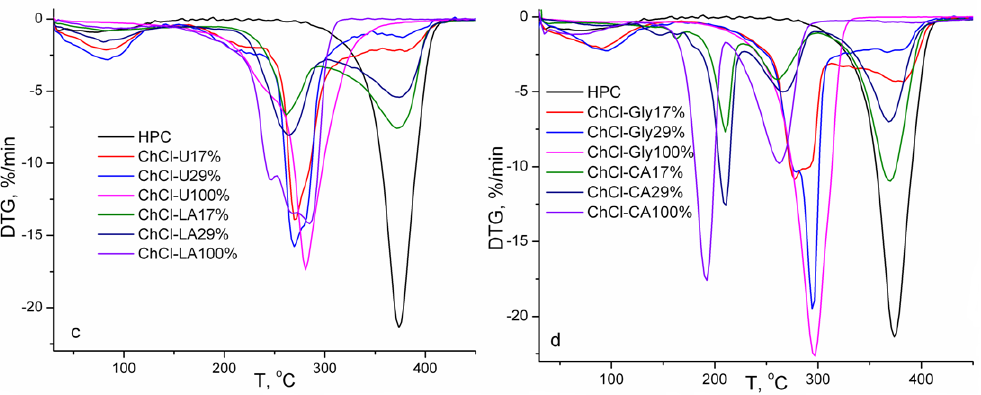
Figure 7. TG and DTG curves of HPC, NADES and HPC-NADES gels (17% and 29% w / w ). Table 2. The thermal characteristics from TG and DTG curves of HPC, NADES and HPC-NADES gels (17% and 29% w / w ).